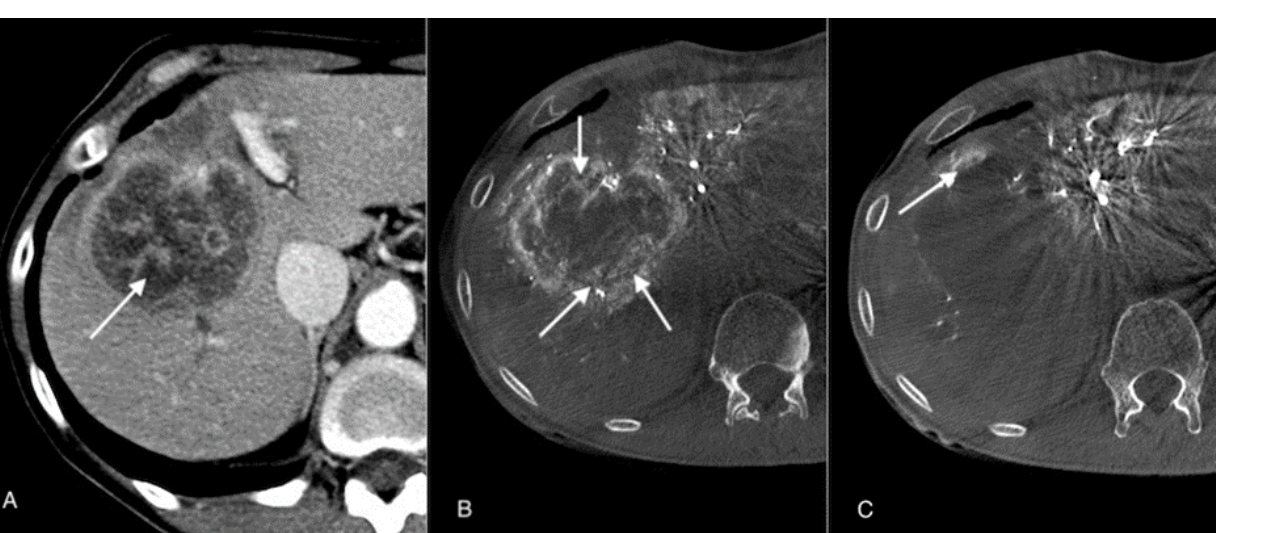
Figure 1. ( A ) Contrast-enhanced CT image before procedure: large metastatic lesion in the right lobe of the liver (arrow). ( B ) Cone-beam computed tomography image before the procedure: visible pathological tumor vessels (arrows). ( C ) Cone-beam computed tomography image three weeks after the procedure: almost complete devascularization of tumor vessels (arrow).